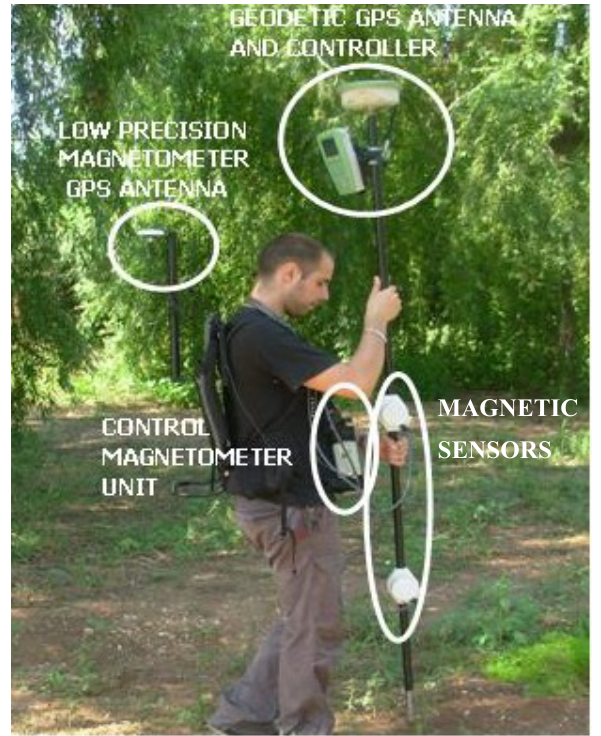
Figure 1. Magnetometer and geodetic GPS integration.